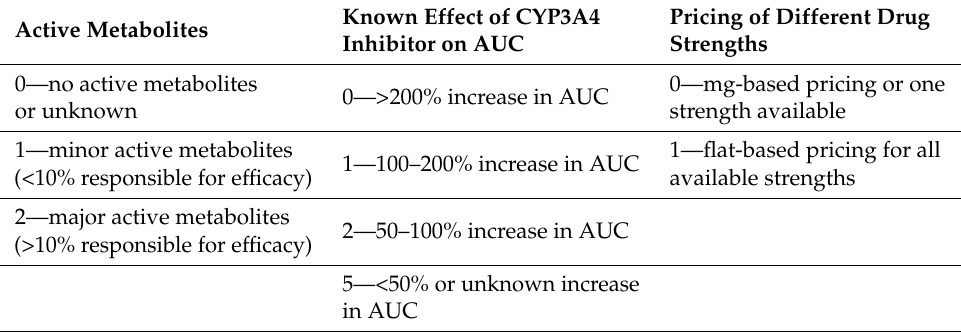
Table 1. Scoring criteria of potential CYP3A4 boosting candidates.